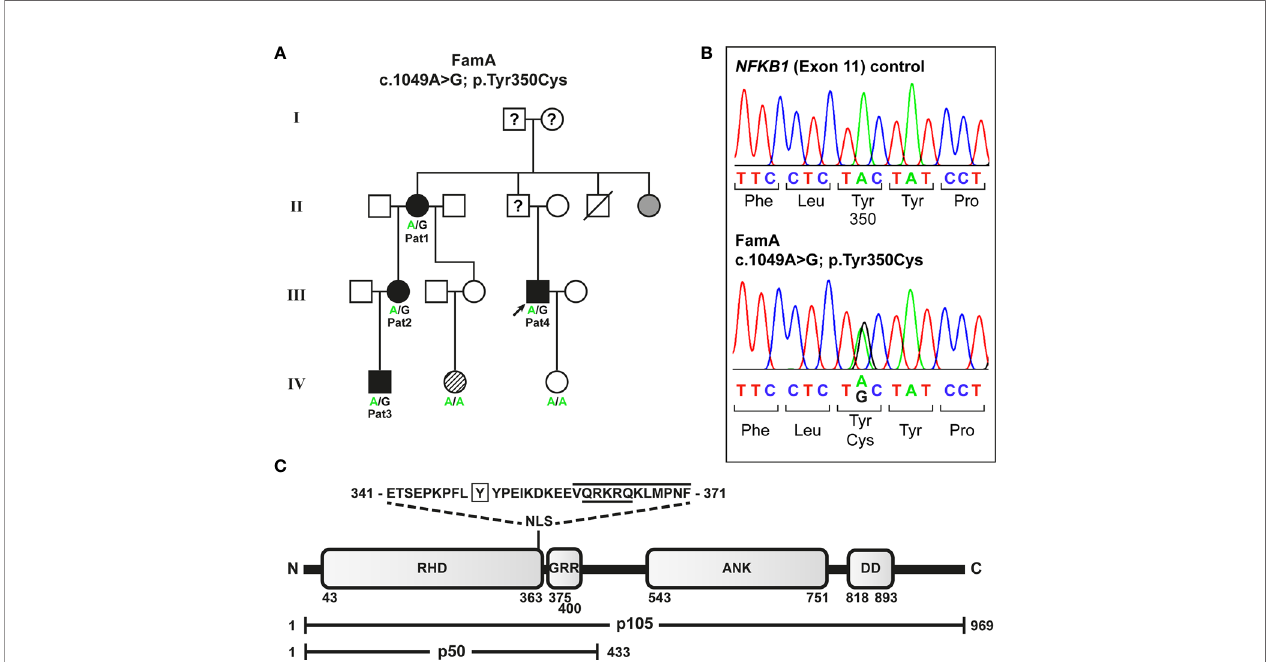
FIGURE 1 | Segregation of a heterozygous NFKB1 missense variant with variable disease phenotypes in a non-consanguineous German CVID family. (A) The missense variant was identi fi ed in patient 4 (index; arrow) by targeted next generation sequencing. Family members tested by Sanger sequencing are indicated. Circles, female; squares, male; fi lled symbols, affected individual, open symbol, healthy member; grey symbol, symptomatic but not tested; hatched symbol, unclear etiology; slash, deceased individual; question mark, unknown status. (B) Sequencing chromatograms con fi rming the heterozygous missense variant in an affected individual. (C) The p.Tyr350Cys amino acid change maps close to the NF- k B1 nuclear localization sequence. Protein domains of the p105 precursor (long horizontal bar) comprise the N-terminal Rel-homology domain (RHD), the nuclear localization sequence (NLS), the central glycine-rich region (GRR), and the C-terminal Ankyrin- repeat domain (ANK) and the death domain (DD). The sequence of the predicted NLS (cNLS Mapper), comprising a bi- (aa341-367; dotted lines) and a monopartite (aa360-371; black line) NLS, and the amino acid position (Y350) affected by the missense change (p.Tyr350Cys) are indicated. The NLS listed in UniProt is underlined. In the mature p50 form (short horizontal bar), which originates from limited proteasomal processing of the C-terminal half of p105, the NLS is exposed and can promote nuclear import. Amino acid positions are indicated by